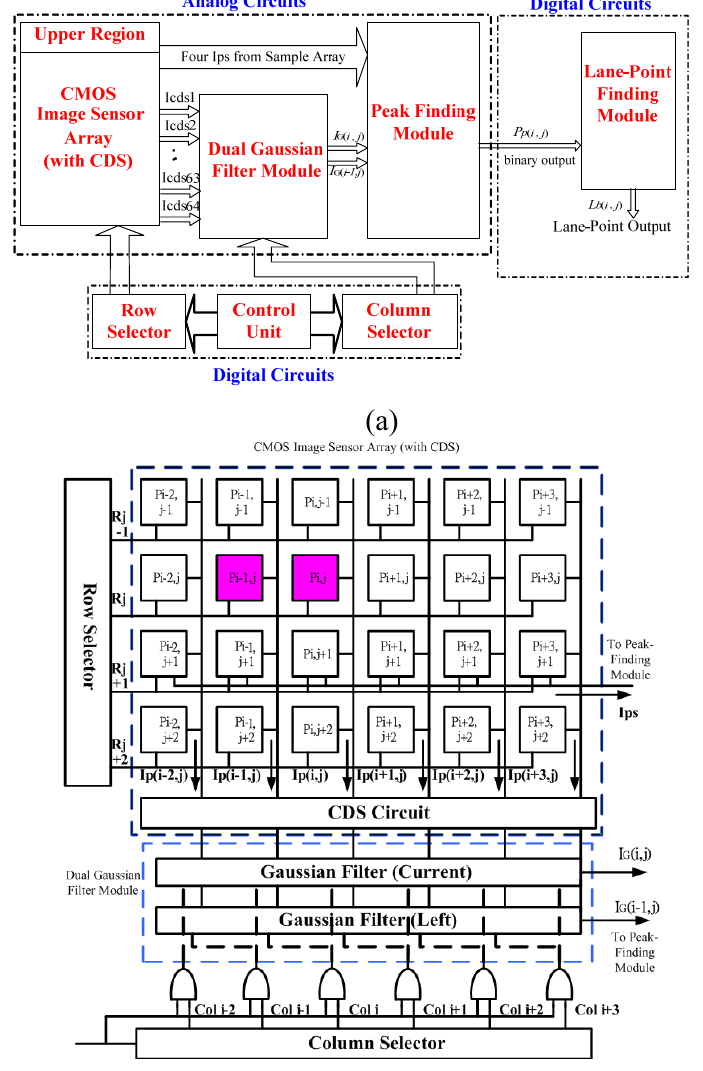
Figure 4. The proposed architectural circuit (a) block diagram (b) signal flow diagram of the proposed mixed signal CMOS imager integrated with lane detection